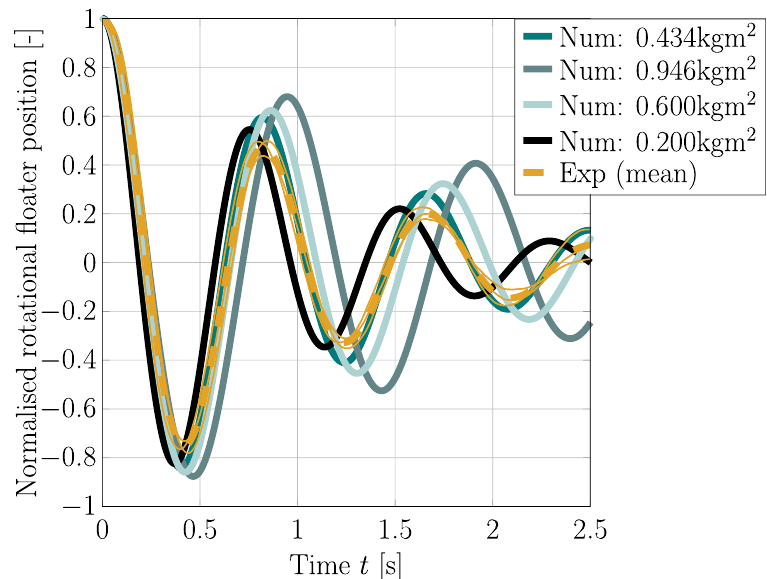
Figure 14. Time trace of the normalised floater position during the free decay